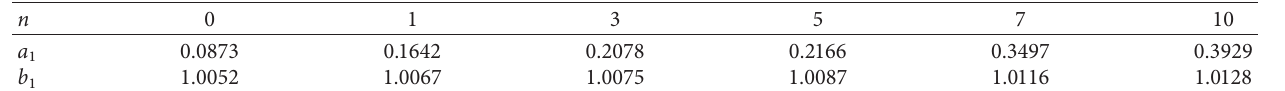
Figure 7: Relationship between F and deviatoric stress under different dry-wet cycles when q is equal to 0. (a) n � 0, (b) n � 1, (c) n � 3, (d) n � 5, (e) n � 7, and (f) n � 10. Table 7: Parameter values of a 1 and b 1